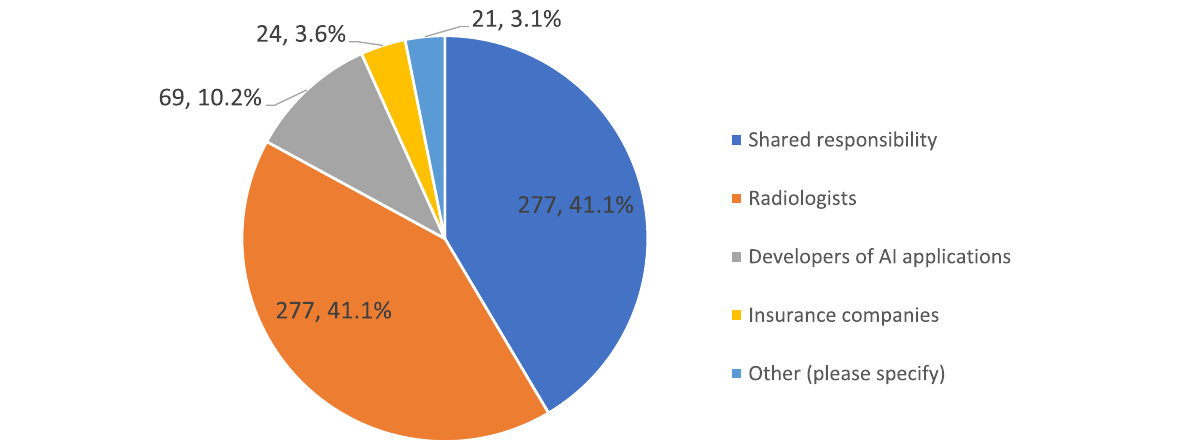
Fig. 5 Distribution of answers related to who should take legal responsibility of AI systems outcome